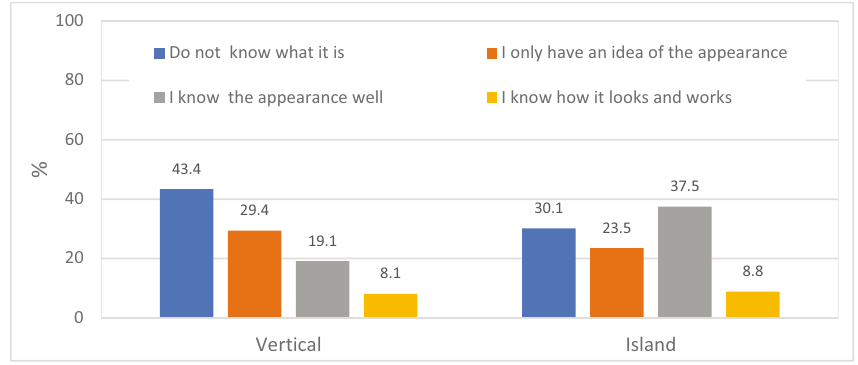
Figure 4: Results for the question: “ Indicate your level of knowledge about each RDC, concerning the disposition in the supermarket ”